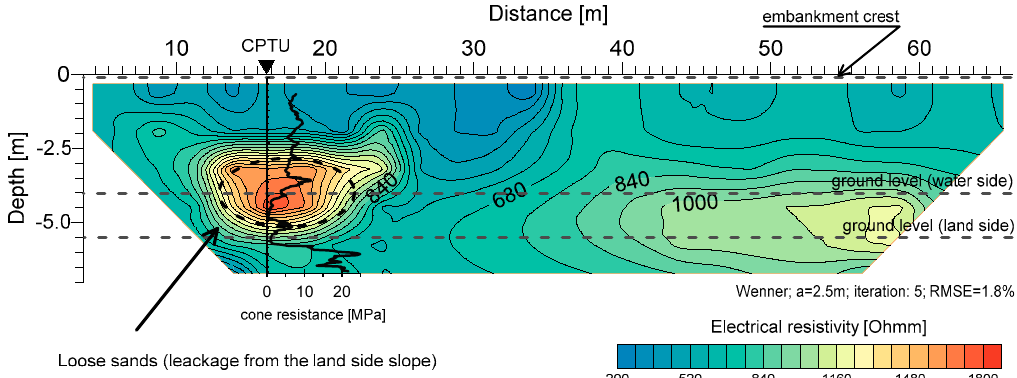
Figure 13. Geoelectrical cross-section through the embankment compared with cone resistance from the CPTU test.